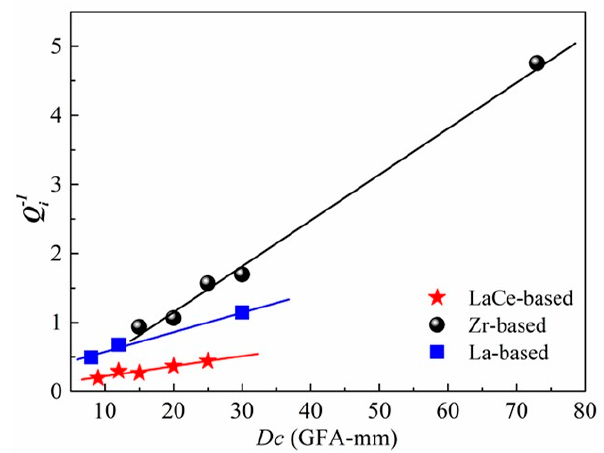
Figure 6. Relationship of GFA and the Q i − 1 magnitude for LaCe-based, Zr-based, and La-based BMGs.